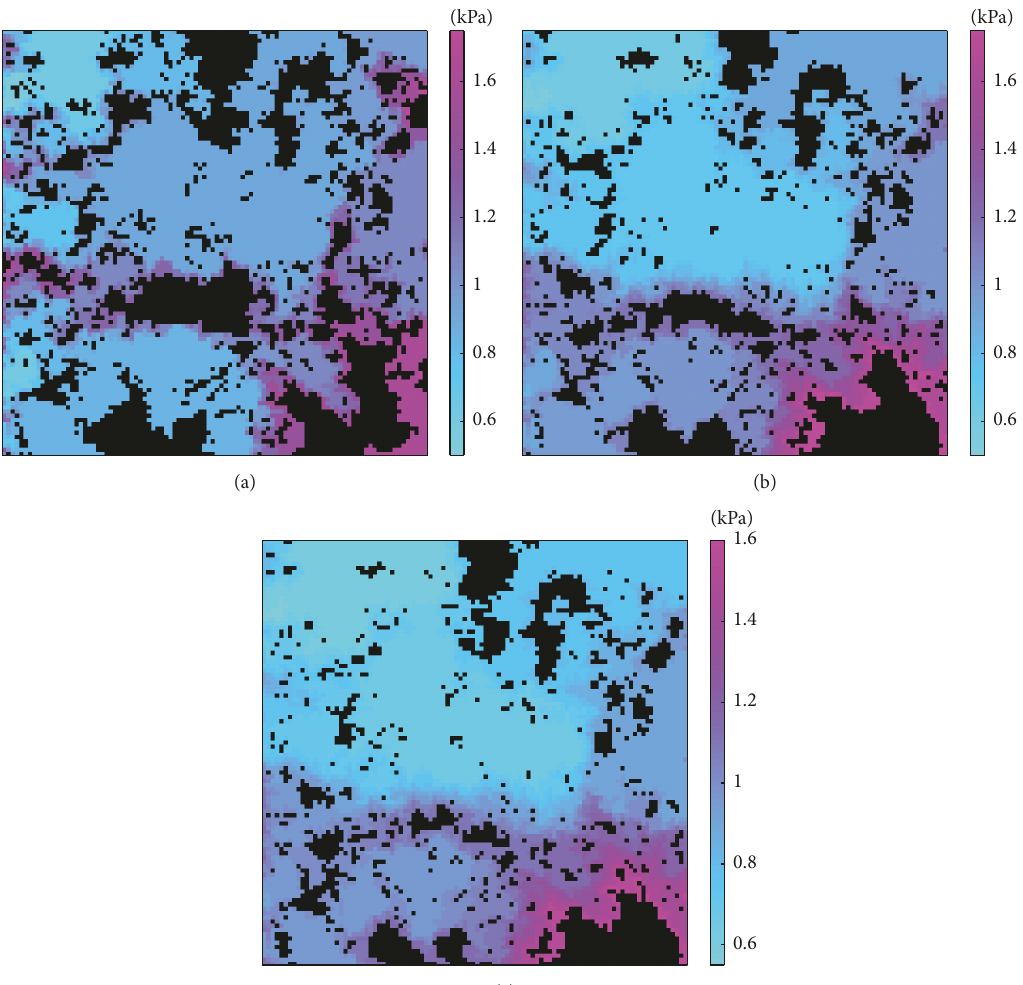
Figure 17: Water saturation maps with different correlation lengths: (a) 𝜆 = 0.08 dm; (b) 𝜆 = 0.36 dm; (c) 𝜆 = 0.64